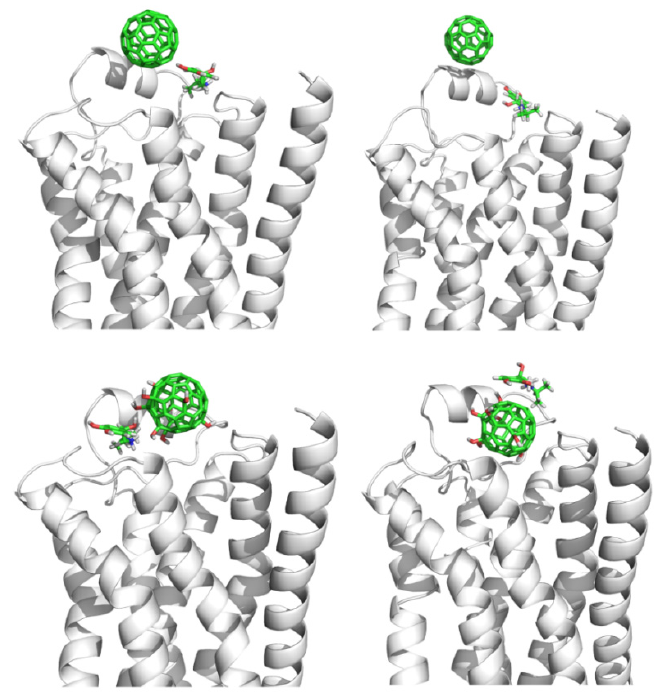
Figure 13. The initial ( left ) and final ( right ) structures of the C 60 _IPT_ex ( upper ) and C 60 (OH) 8 _IPT_ex ( lower ) systems. The C 60 , C 60 (OH) 8 , and isoproterenols are colored green and the β 2 ARs are grey.